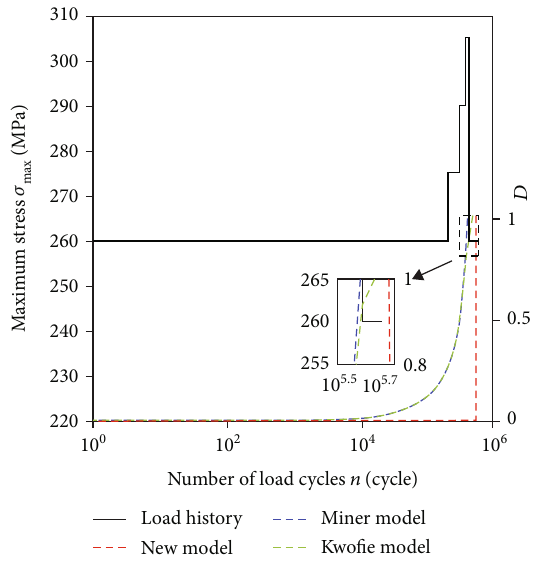
Figure 13: Comparison of experimentally obtained and corresponding theoretical remaining life values predicted by the Miner, Kwo fi e, and proposed new model for 6082-T6 aluminium alloy under fi ve-level cyclic loading in the range 260 – 275 – 290 – 305 – 260 MPa.